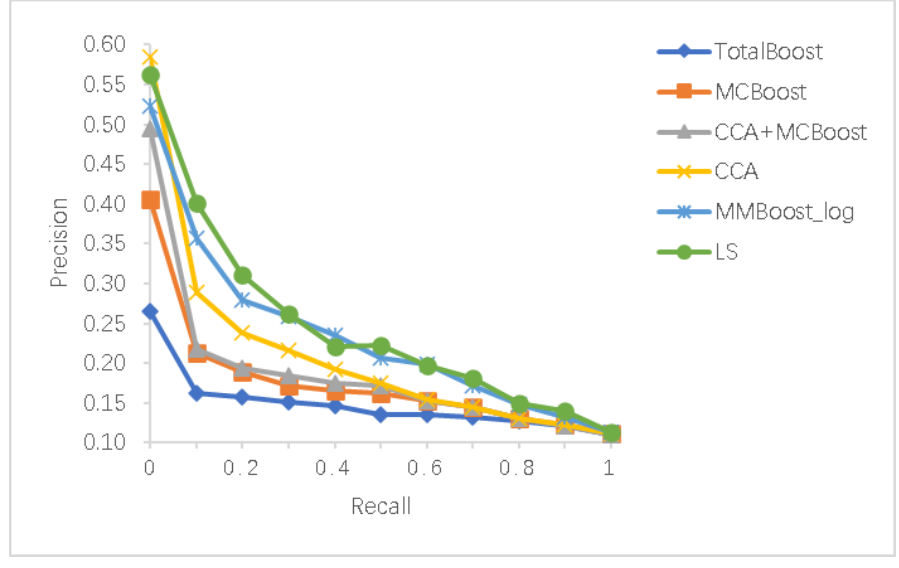
Figure 5. Precision–recall curves for text retrieval images.